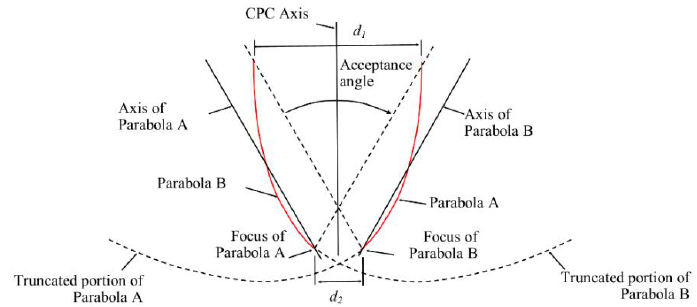
Figure 1. Compound Parabolic Collector (CPC) [22].